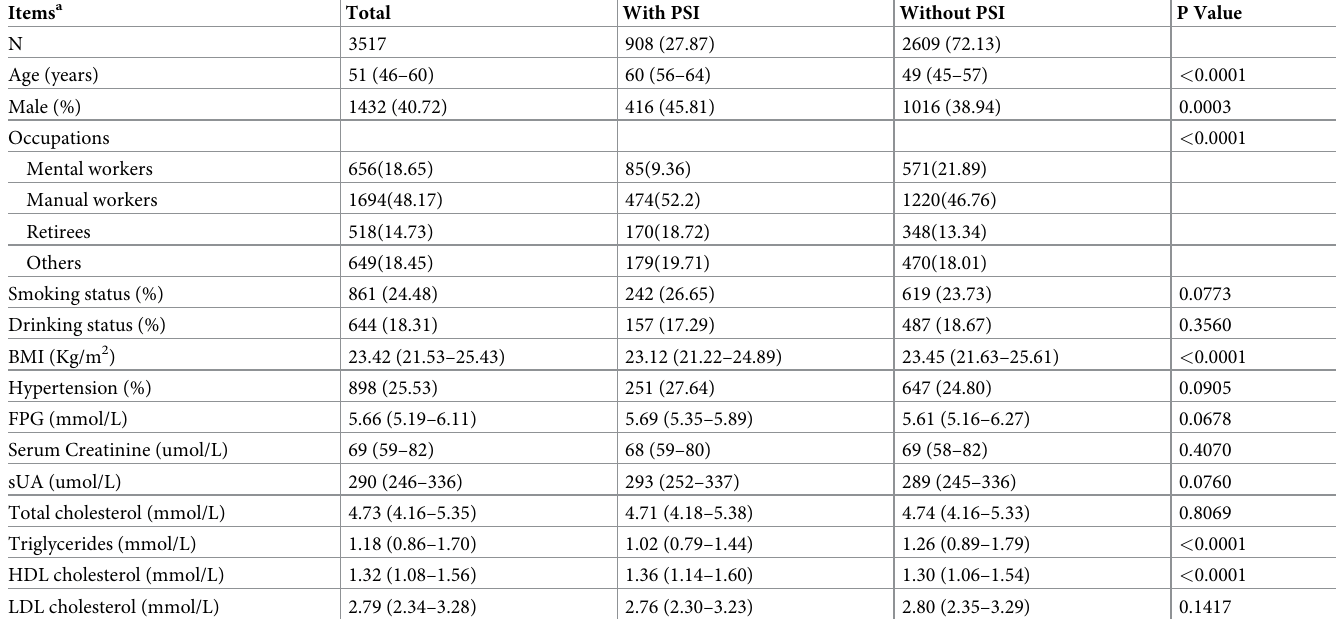
Table 1. Characteristics of the study population with and without PSI.